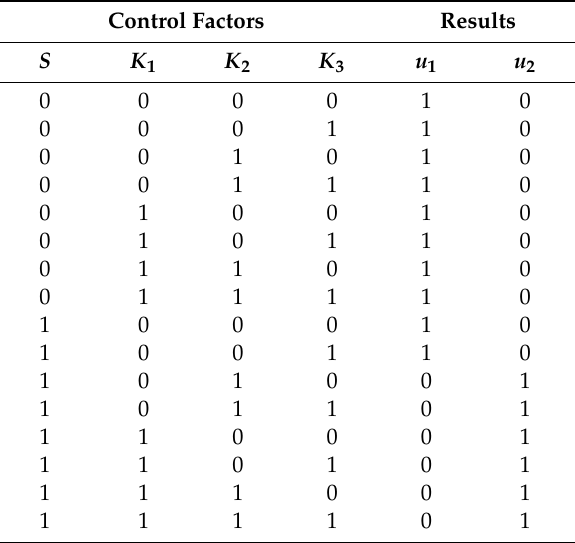
Table 1. The boost converter operating